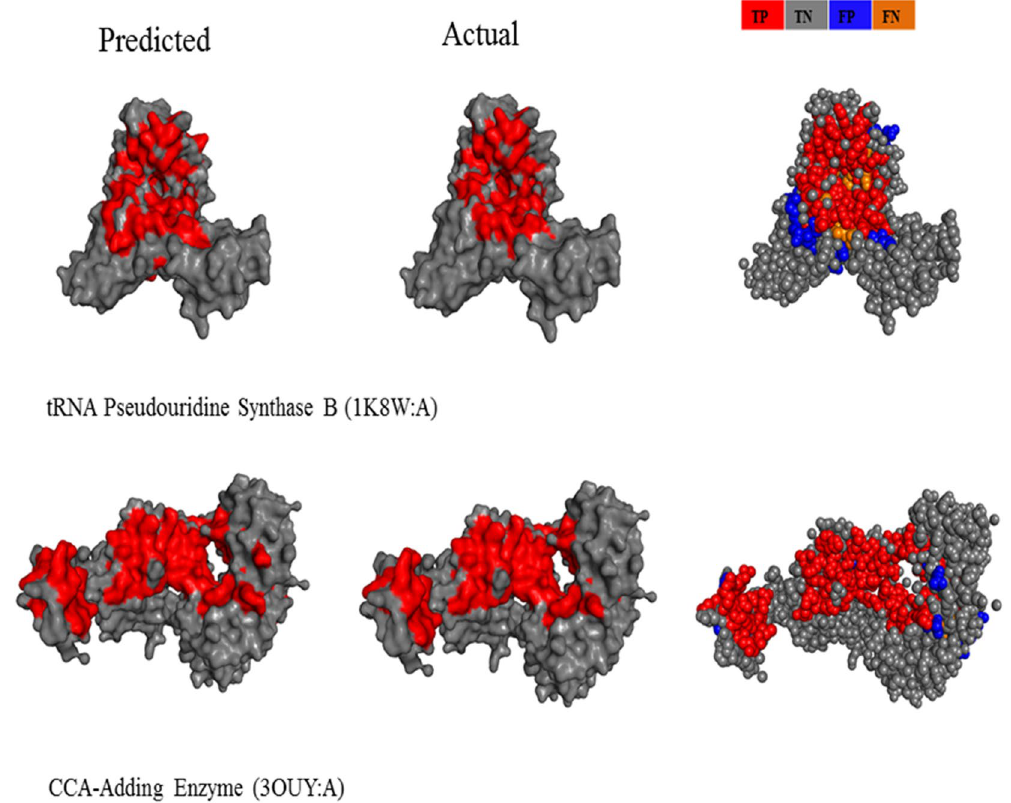
Figure 5. Examples of predicted RNA-protein interacting complexes. The two examples are tRNA Pseudouridine Synthase B and CCA-Adding Enzyme Predicted RNA binding sites are shown in red and predicted non-binding sites in gray (left panels). Actual RNA binding sites in red and actual non-binding sites in gray (middle panels). The performance of prediction for individual residues, with true positives (TP) shown in red, false positives (FP) in blue, false negatives (FN) in orange, and true negatives (TNs) in gray (right panels). Thus, red + orange residues correspond to the actual binding residues; red + blue residues correspond to the predicted binding residues. All structure diagrams were generated using PyMol